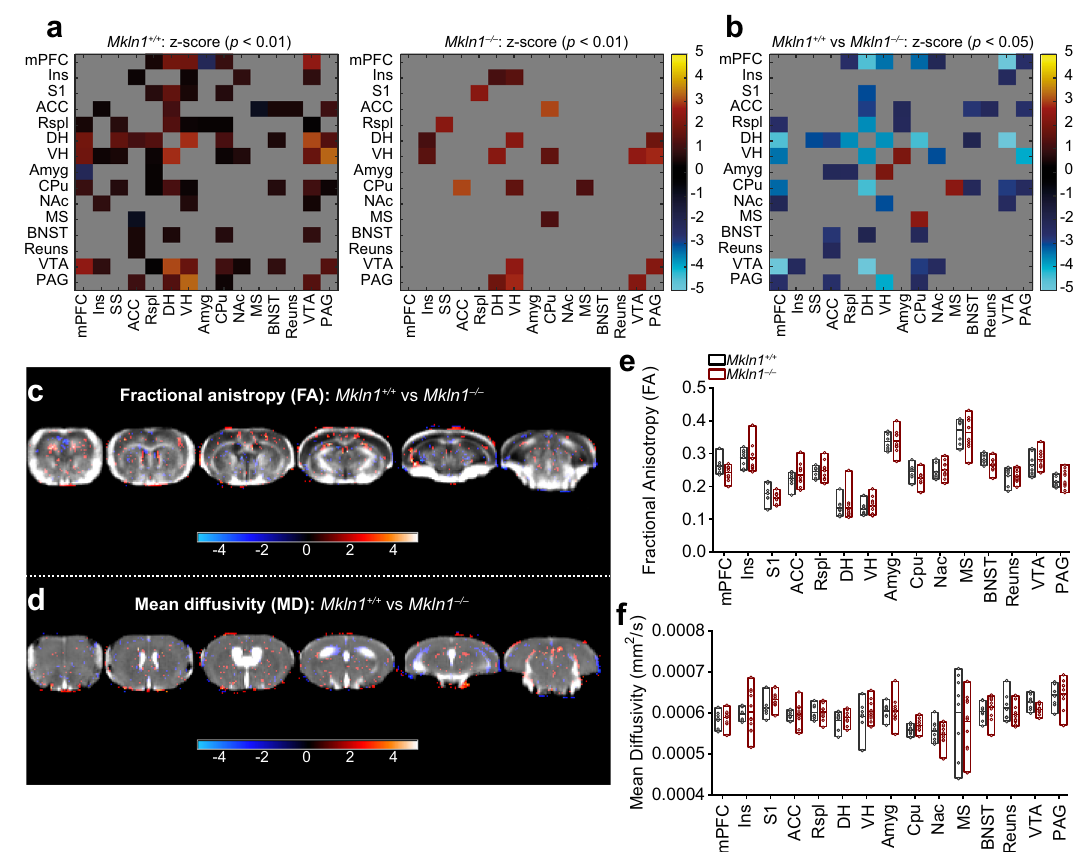
Fig. 4 Widespread alterations in resting-state functional connectivity but largely intact brain tissue microstructure in Mkln1-null mice. a , b Resting- state functional connectivity (FC) analyses of BOLD signal synchronization of fi fteen regions of interest (ROI). a Connectivity matrices of Mkln1 + / + mice (left panel) and Mkln1 – / – mice (right panel), in which functional correlations ( z -score) between pairs of regions are depicted by color scale. Compared with Mkln1 + / + control mice, Mkln1 – / – mice displayed visibly weaker interregional FC. b Statistical analyses of FC strength are depicted as a matrix, revealing the direction of signi fi cant genotype differences for each ROI-ROI connection. Relative to Mkln1 + / + control mice, blue-to-light blue elements indicate regions of signi fi cantly reduced FC, while red elements depict regions exhibiting signi fi cantly increased FC in Mkln1 – / – mice. c – f Diffusion tensor imaging (DTI) in Mkln1 + / + and Mkln1 – / – mice. Diffusion parameters (fractional anisotropy (FA) and mean diffusivity (MD) were analyzed using an ROI-based approach. ( c , d ) Representative set of six axial FA and MD images. The FA ( c ) and MD ( d ) maps are overlaid with resulting signi fi cant t values ( P < 0.05) following a voxel-wise t -test comparing the DTI data between the two genotype groups. Also shown are the z -score values in a color scale ranging from − 4 to 4. e , f Bar graphs illustrate genotype-dependent comparisons of FA and MD values in the different ROIs. Values represent mean ± SEM. ( Mkln1 + / + ( N = 8) ; Mkln1 – / – ( N = 11). Brain region abbreviations are de fi ned in Supplementary Fig.